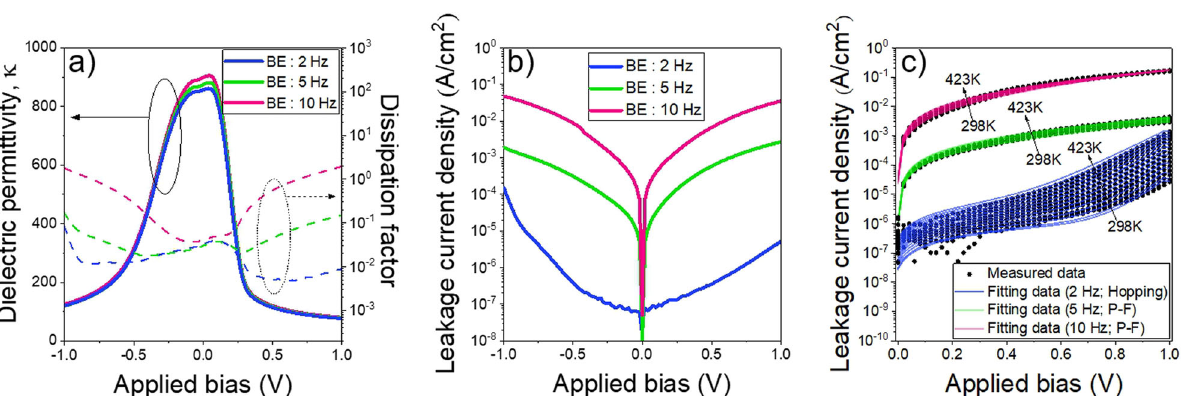
Fig. 3 Electrical properties of the SrRuO3/Ba0.5Sr0.5TiO3/SrRuO3 capacitors. a Capacitance – voltage characteristics of each capacitor; dielectric permittivity and dissipation factors are represented by solid and dashed lines, respectively. b Current – voltage characteristics of each capacitor. c Current – voltage characteristics at different temperatures (298 – 423 K) and the corresponding fi ts based on different conduction